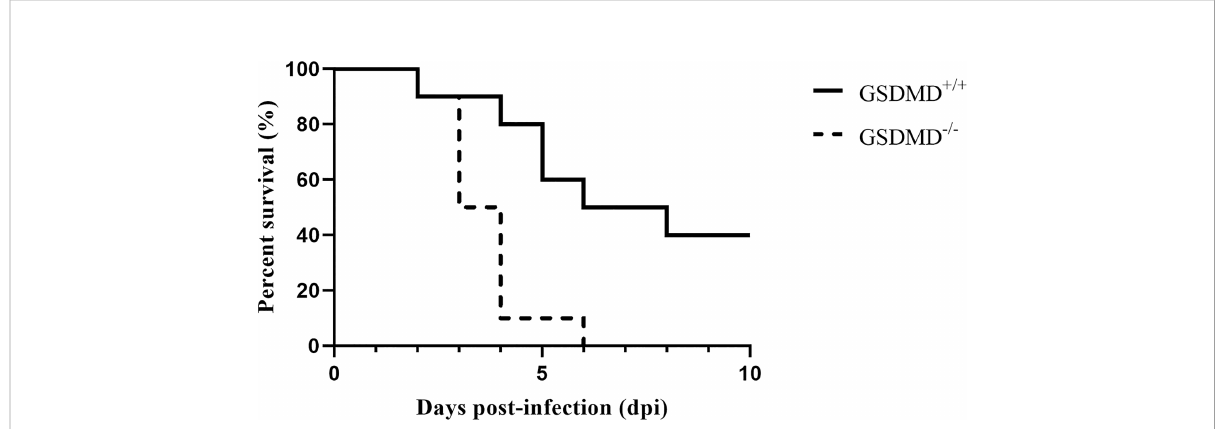
FIGURE 1 GSDMD is protective in SEZ infection. Mice were intraperitoneally injected with SEZ (10 6 CFU), and their survival was monitored for 10 days (n=10 mice per group). The experiment was conducted with 3 replicates. The log rank Kaplan – Meier test was used for statistical